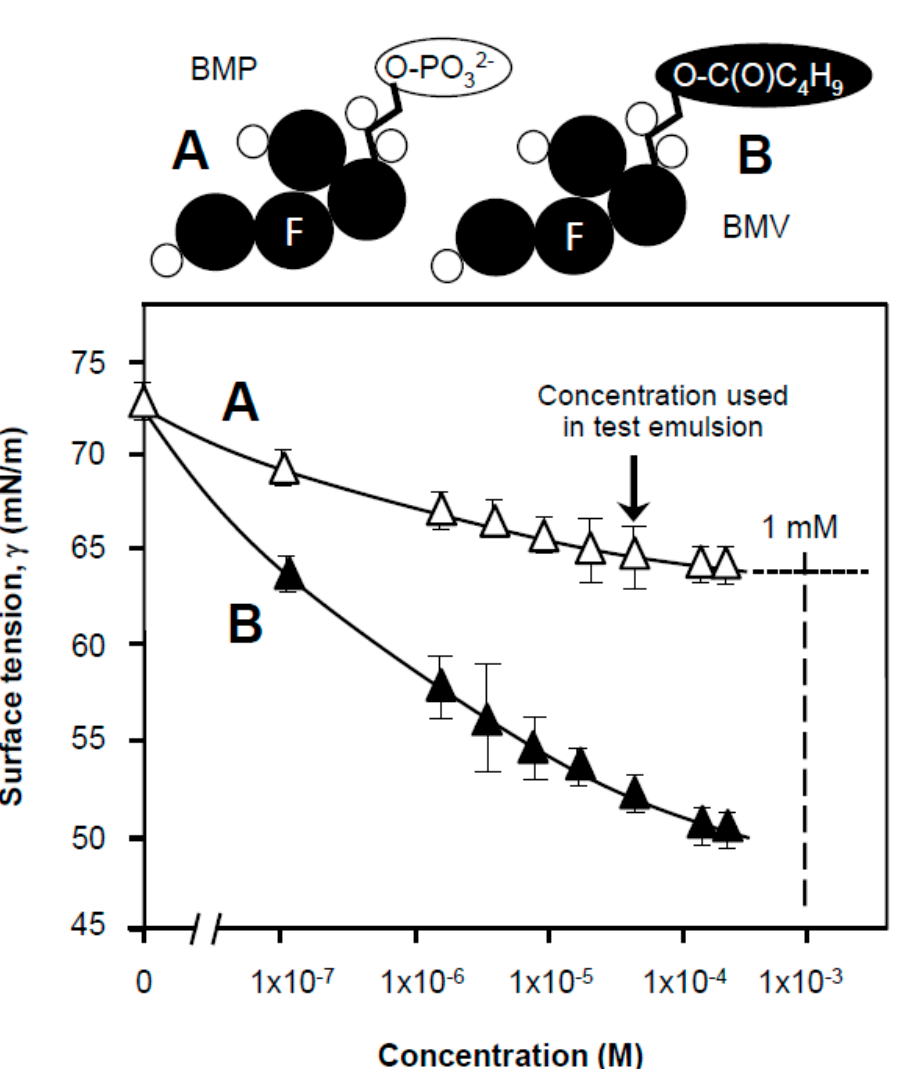
Figure 5. Surface tension for purified drug solutions at 20 °C as a function of increasing bulk concentration (where error bars are not shown they are of a smaller magnitude than the dimensions of the symbols; lines represent an aid to the eye to show the trend in the data). The drug samples were betamethasone 17-valerate (BMV) ( ▲ ) and betamethasone 21-phosphate (BMP) as a sodium salt ( △ ). All solutions used for samples were prepared from surface chemically pure 50 mM sodium phosphate buffered water, pH 7.0. In the simplified molecular structures appended to the figure, black coloration is used to indicate hydrophobicity, with “F” representing a fluorinated component.